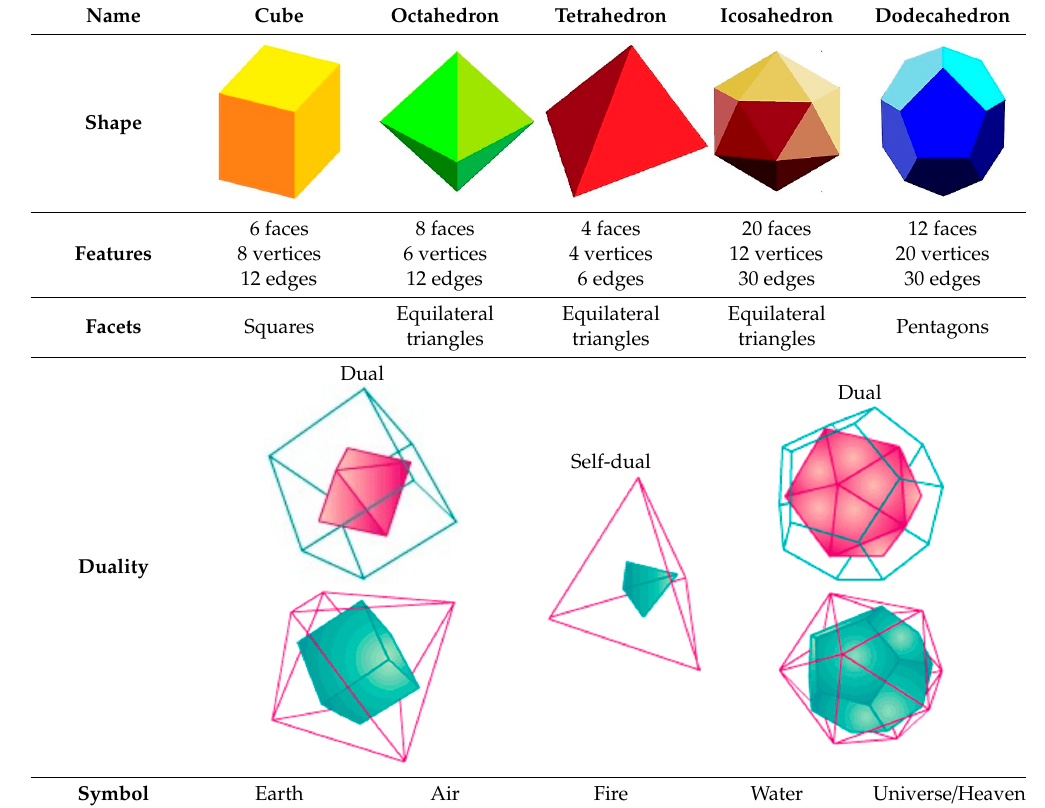
Table 1. The five platonic solids. Their shapes and features are reported, as well as their duality and symbolic